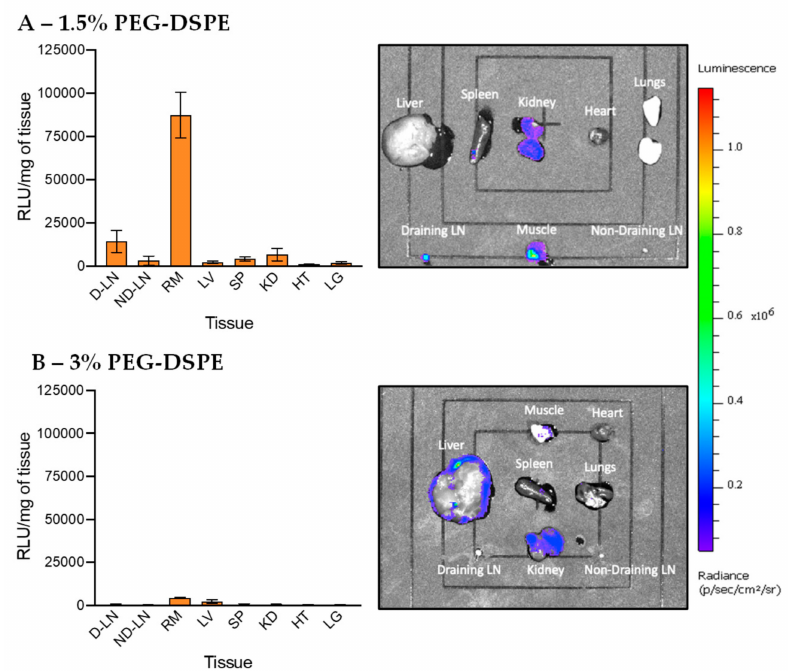
Figure 5. In vivo transfection of LNPs stabilized by PEG-DSPE at ( A ) 1.5% and ( B ) 3%. The graphs on the left show the luminescence relative light unit (RLU) of homogenized tissues recorded by the plate reader and the right IVIS images show the luminescence of whole tissues. The abbreviations of tissues are draining lymph node (D-LN), non-draining lymph node (ND-LN), right muscle (RM), liver (LV), spleen (SP), kidney (KD), heart (HT) and lungs